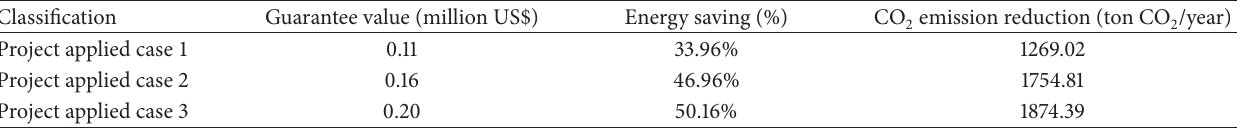
emission reduction for each case. 2